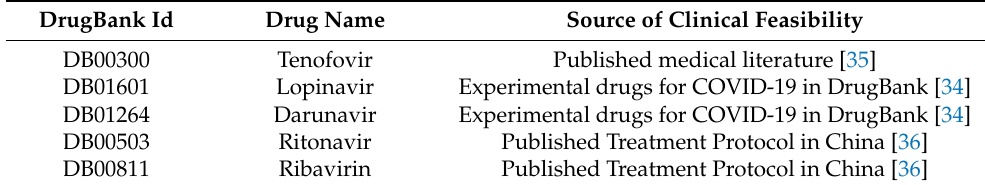
Table 3. Clinically proven drugs in our drug candidates.